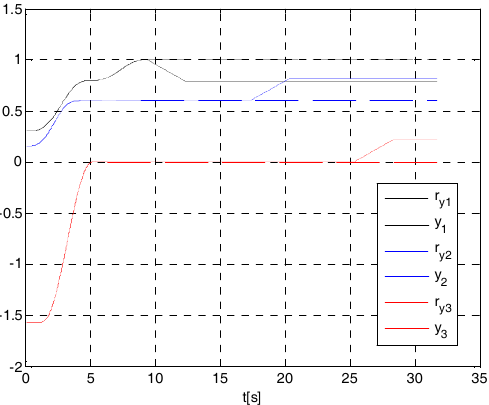
Figure 34. Behaviors of r yi and y i assuming that the impedance is as shown in Figure 30b.